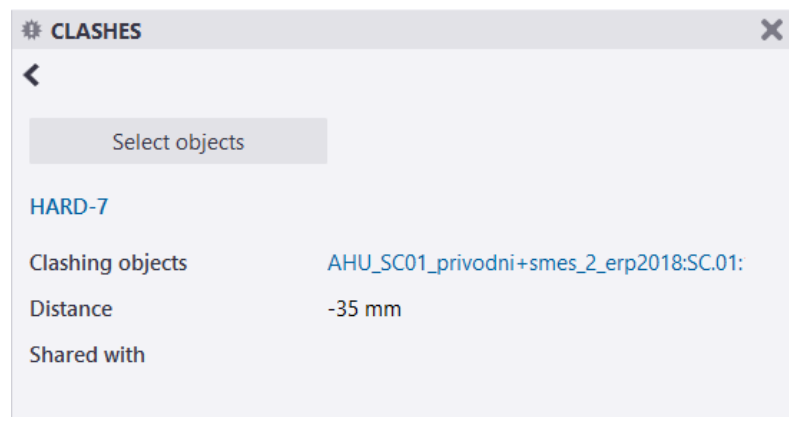
Figure 4: Information of the selected clash,